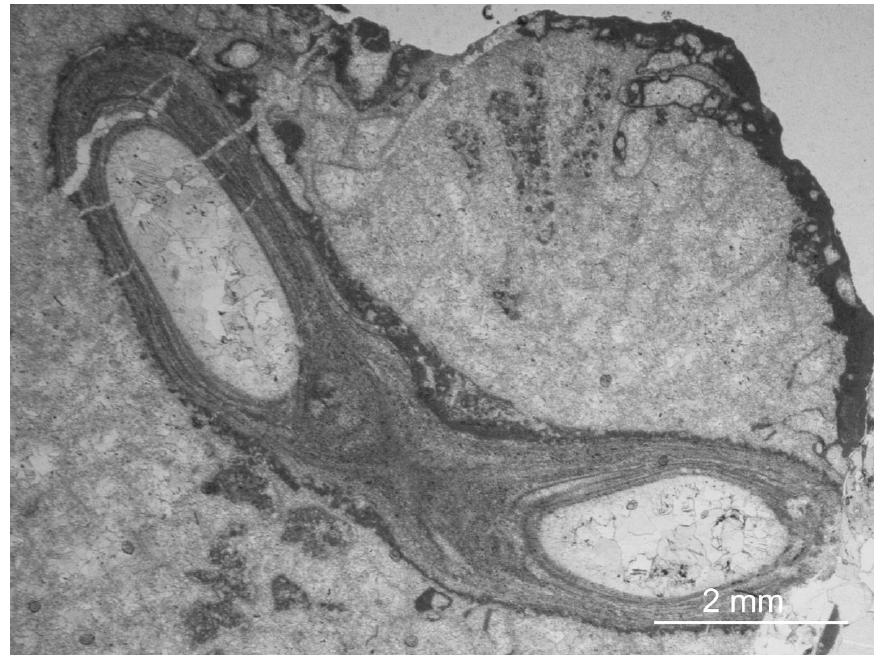
Figure 4 Figure 4. Growth lamellae in the thick-walled worm tube in Calamophylliopsis sp.;